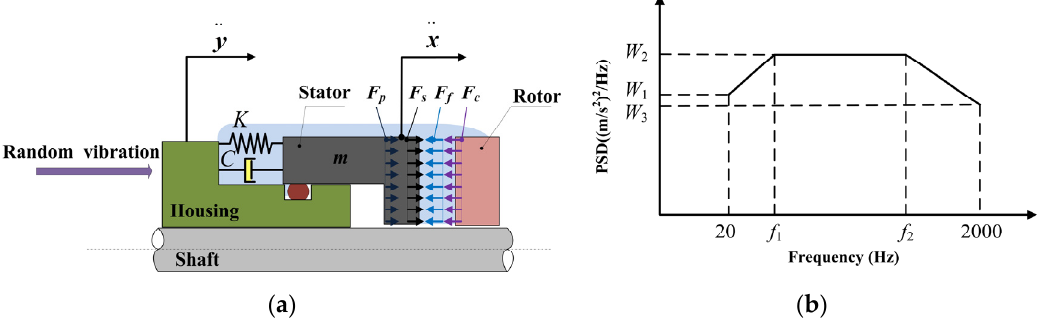
Figure 2. ( a ) Mass ‐ spring ‐ damping model; ( b ) acceleration power spectral density (PSD).